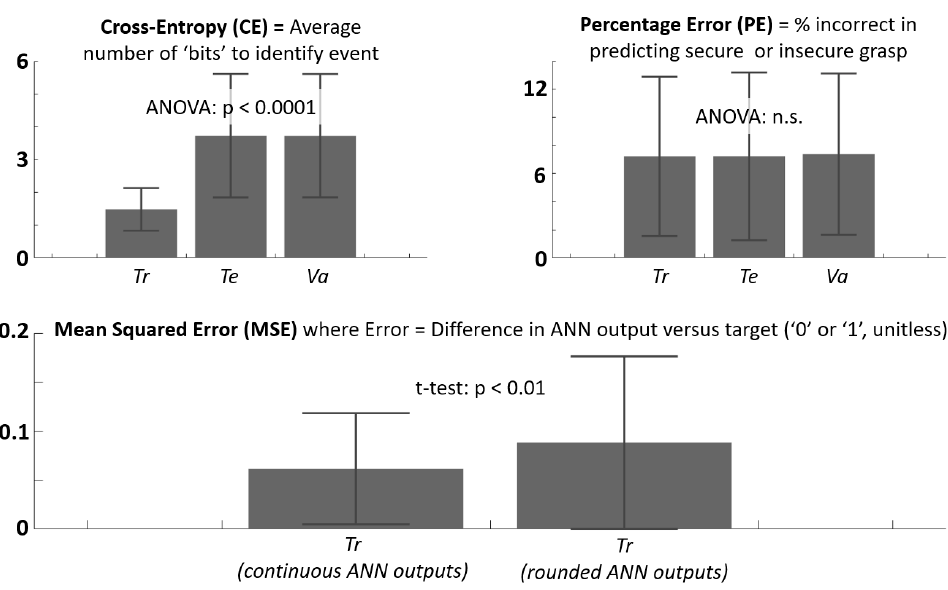
Figure 2. Mean values shown for artificial neural network (ANN) training parameters (CE, PE, two versions of MSE). Results for CE and PE shown for training (Tr), testing (Te), and validation (Va) data sets. Minimization of CE was objective function during training. Computation for MSE during training shown for continuous ANN output (any value over [0,1]) versus rounded ANN output (ANN output converted to either ‘0’ or ‘1’ if continuous output is > or <0.5, respectively). Note: p -value > 0.05 is not significant (n.s.). Table 1. Mean value comparisons for ANN training parameters.